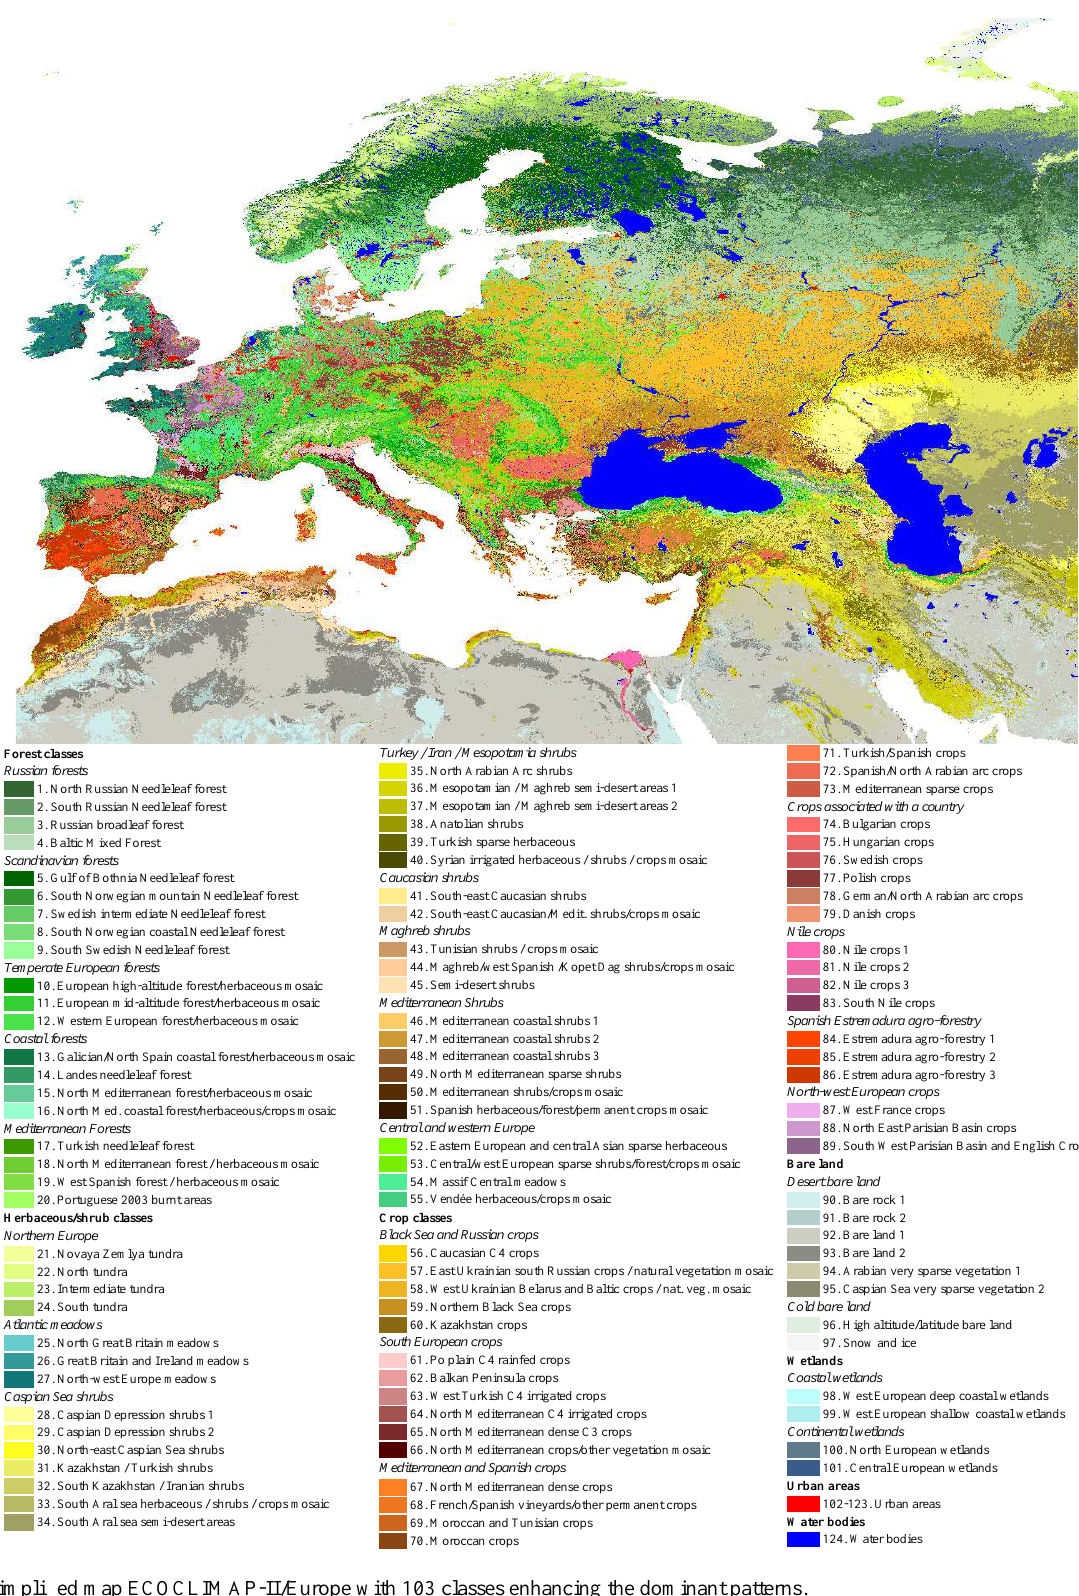
Fig. 7. Simplified map ECOCLIMAP-II/Europe with 103 classes enhancing the dominant